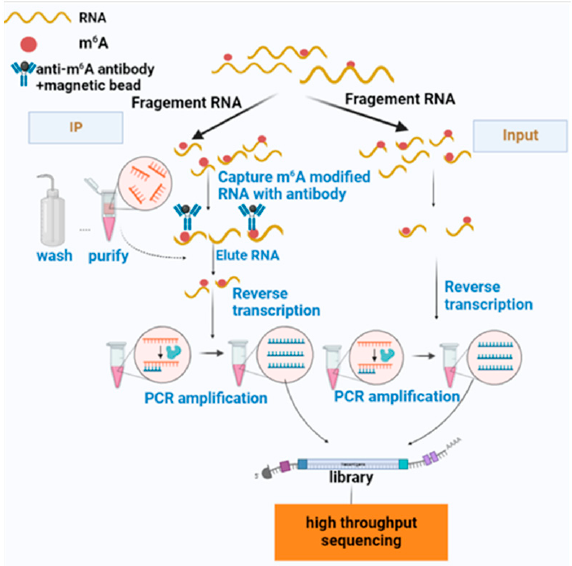
Figure 4. Specific process of MeRIP-seq. This figure introduces the operation process of MeRIP seq. This technique has been extensively used to study m 6 A modifications because it is easy, fast, and relatively inexpensive. It enables the qualitative analysis of mRNA regions under- going hypermethylation. Wang et al. detected 9085 m 6 A methylation peaks by performing MeRIP-seq analysis on the transcriptome of velvet goat skin tissue. The transcriptome and differential peaks were then combined to screen out 19 differentially expressed genes that contain RNA methylation modifications associated with velvet growth [52]. In addition, MeRIP-seq has been widely used as an assay for investigating the mechanisms related to cancer regulation by measuring m 6 A methylation modifications. Yang et al. identified m 6 A modifications in the EOC transcriptome of endometrial ovarian cancer by MeRIP-seq for the first time and described methylated m 6 A to modify differentially expressed genes. This provides a new direction for the underlying molecular mechanisms and signaling pathways of EOC development [53]. During a comprehensive analysis of mRNA m 6 A modifications in human colorectal cancer, Li et al. conducted a combined analysis by MeRIP-seq and RNA-seq to predict RNA-binding proteins and identify methylation-related genes FMR1, IGF2BP2, and IGF2BP3 that may be involved in the development of CRC [54]. At this stage, MeRIP-seq can only identify regions of m 6 A hypermethylation but cannot realize single-base resolution